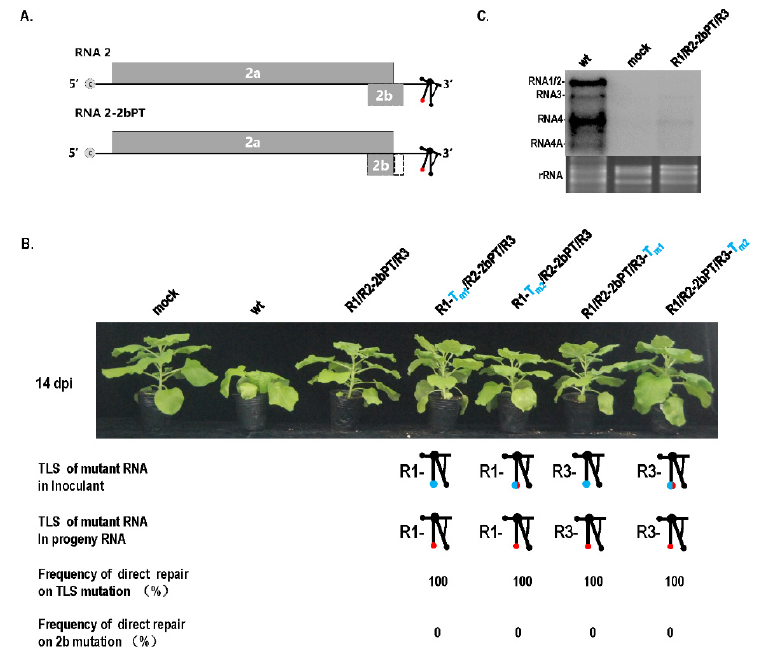
Figure 4. Mutation repair of the TLS mutation of RNA1 or RNA3 in the presence of 2b pre-termination in RNA2. ( A ) Schematics of 2b pre-termination mutant in RNA2. The dotted area indicates the partial deletion of partial 2b ORF caused by the pre-termination of 2b. PT—pre-termination. ( B ) Mutation repair of the TLS mutation of RNA1 or RNA3 in the presence of 2b pre-terminated RNA2. ( C ) Effect of 2b pre-termination on the RNA accumulation of CMV. wt—RNA1/RNA2/RNA3 of wild-type CMV Fny . R2-2bPT—mutant of 2b resulted from pre-termination.